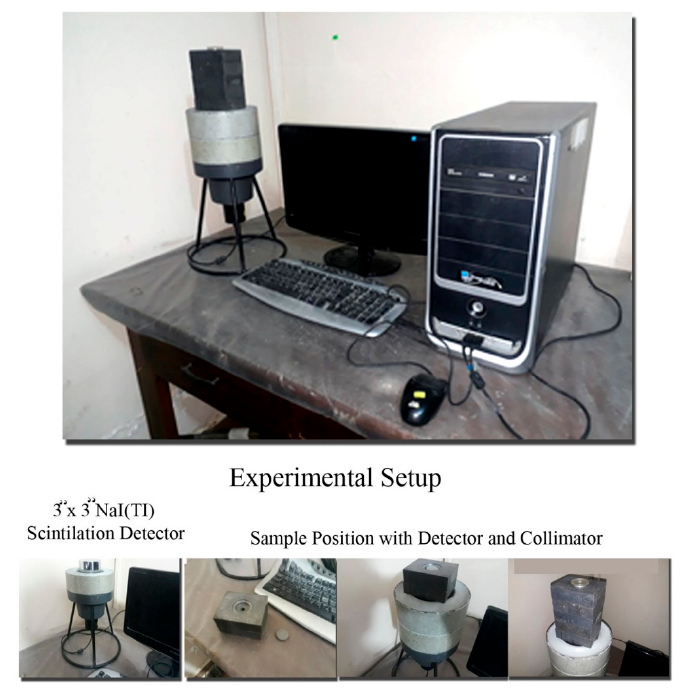
Figure 4. The experimental setup arrangement for gamma-ray measurements. Table 3. Standard radioactive point source energies.